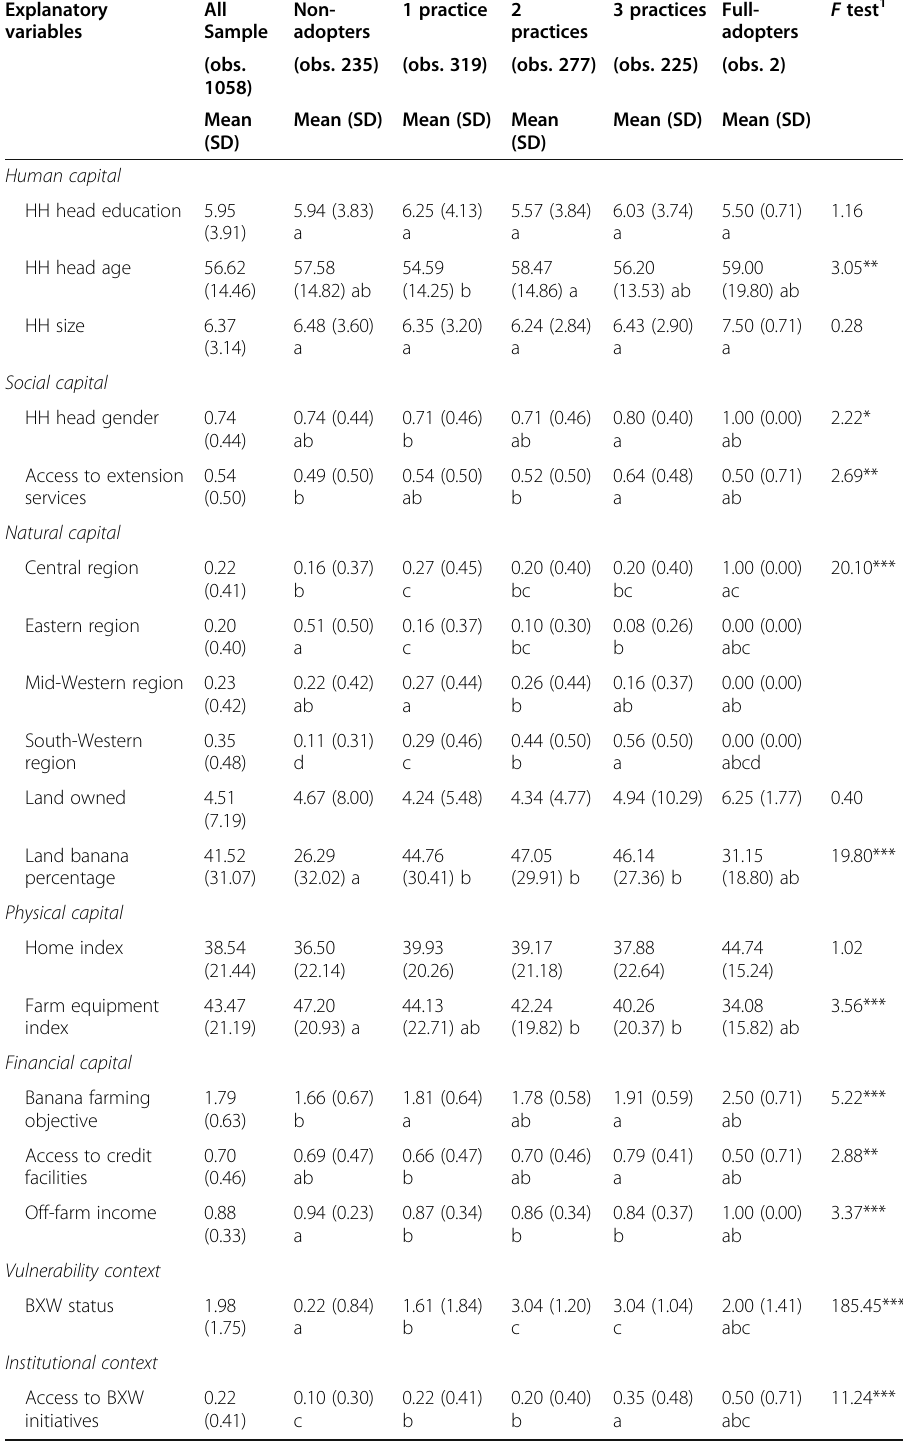
Table 3 Descriptive statistics of the explanatory